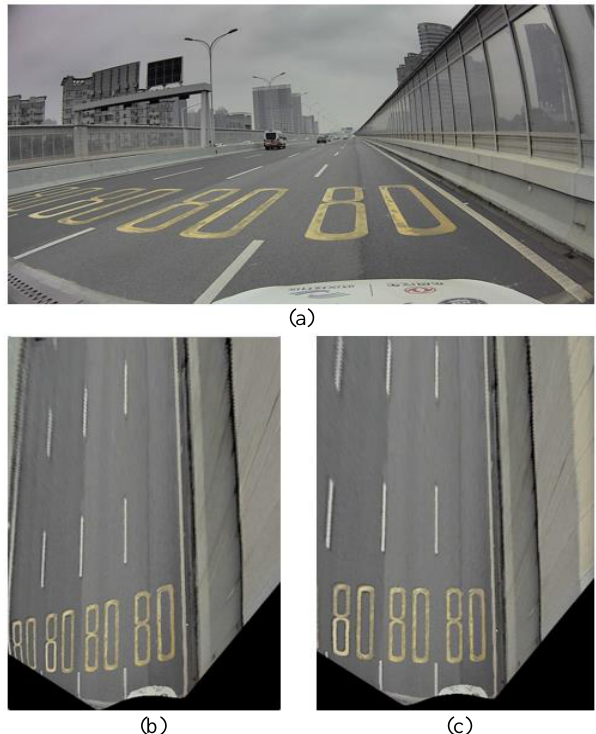
(b) Figure 1 . Bird’s eye view (BEV) and the effect of camera’s roll angle. (a) An image captured by an onboard camera whose roll angle is not zero. (b) BEV with zero-roll hypothesis. (c) BEV considering the roll angle